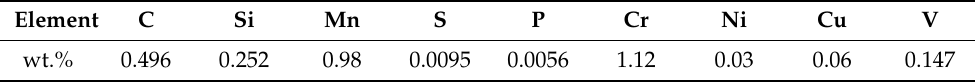
Table 1. Chemical composition (wt.%) of the 51CrV4 spring steel before heat treatment.